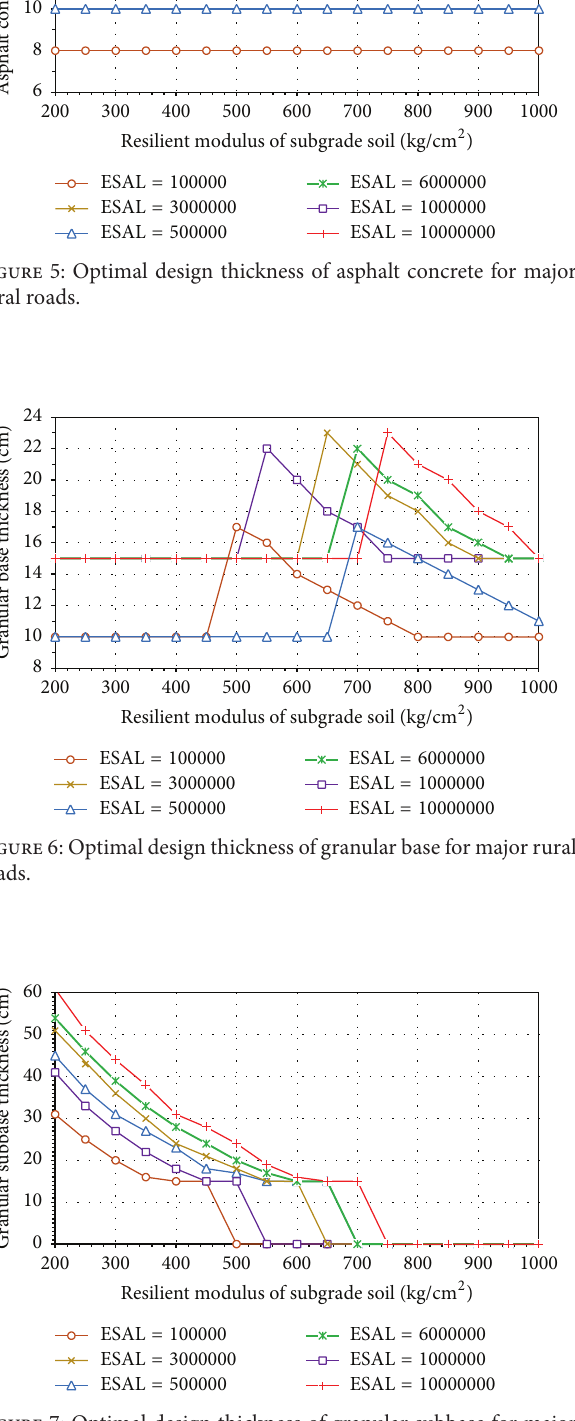
Figure 7: Optimal design thickness of granular subbase for major rural roads.